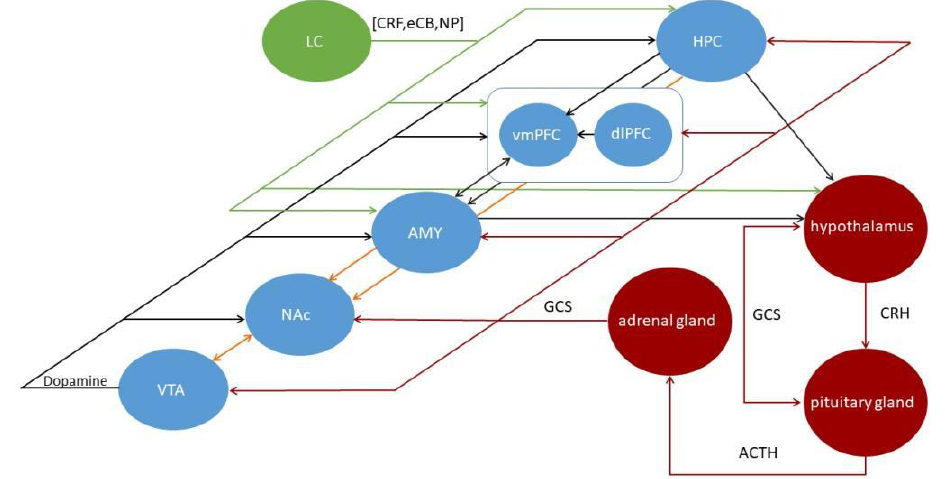
Figure 1. The illustration of the predominant brain regions and circuits is generally thought to mediate the processing of reward (orange), HPA (red), and NE system (green) in the human brain. The NAc is usually the central node of reward circuits, including the DAe input from the VTA and excitatory input from other limbic structures. CRH from the hypothalamus stimulates ACTH release from the anterior pituitary into the bloodstream, then ACTH induces GCS release from the adrenal gland. GCS mediates negative feedback in the HPA axis to reduce the stress response. GCS also affects the circuitry via the GCS receptors, triggering molecular and cellular. The primary stress-related central NE system originates in the LC and plays an integral role in the comorbidity. Some of the many connections that link elements of the comorbidity are illustrated by black lines. LC, locus coeruleus; CRF, corticotropin-releasing factor; eCB, endocannabinoid; NP, neuropeptide; HPC, hippocampus; vmPFC, ventromedial prefrontal cortex; dlPFC, dorsolateral prefrontal cortex; AMY, amygdala; NAc, nucleus accumbens; VTA, ventral tegmental area; GCS, glucocorticoids; CRH, corticotropin-releasing hormone; ACTH, adrenocorticotrophic hormone; NE, norepinephrine.